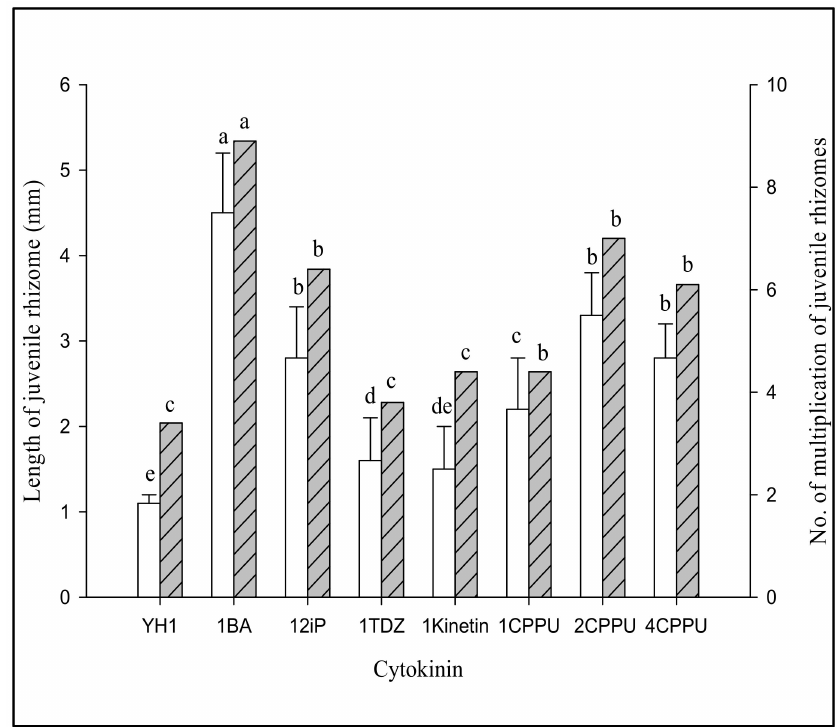
Figure 4. Effect of different cytokinin on proliferation of G. elata juvenile rhizomes after 8 weeks in YH1 culture medium. Each value is expressed as mean ± SD (n = 5). Means followed by the different letter(s) are significantly different at p < 0.05 by Fisher’s protected LSD